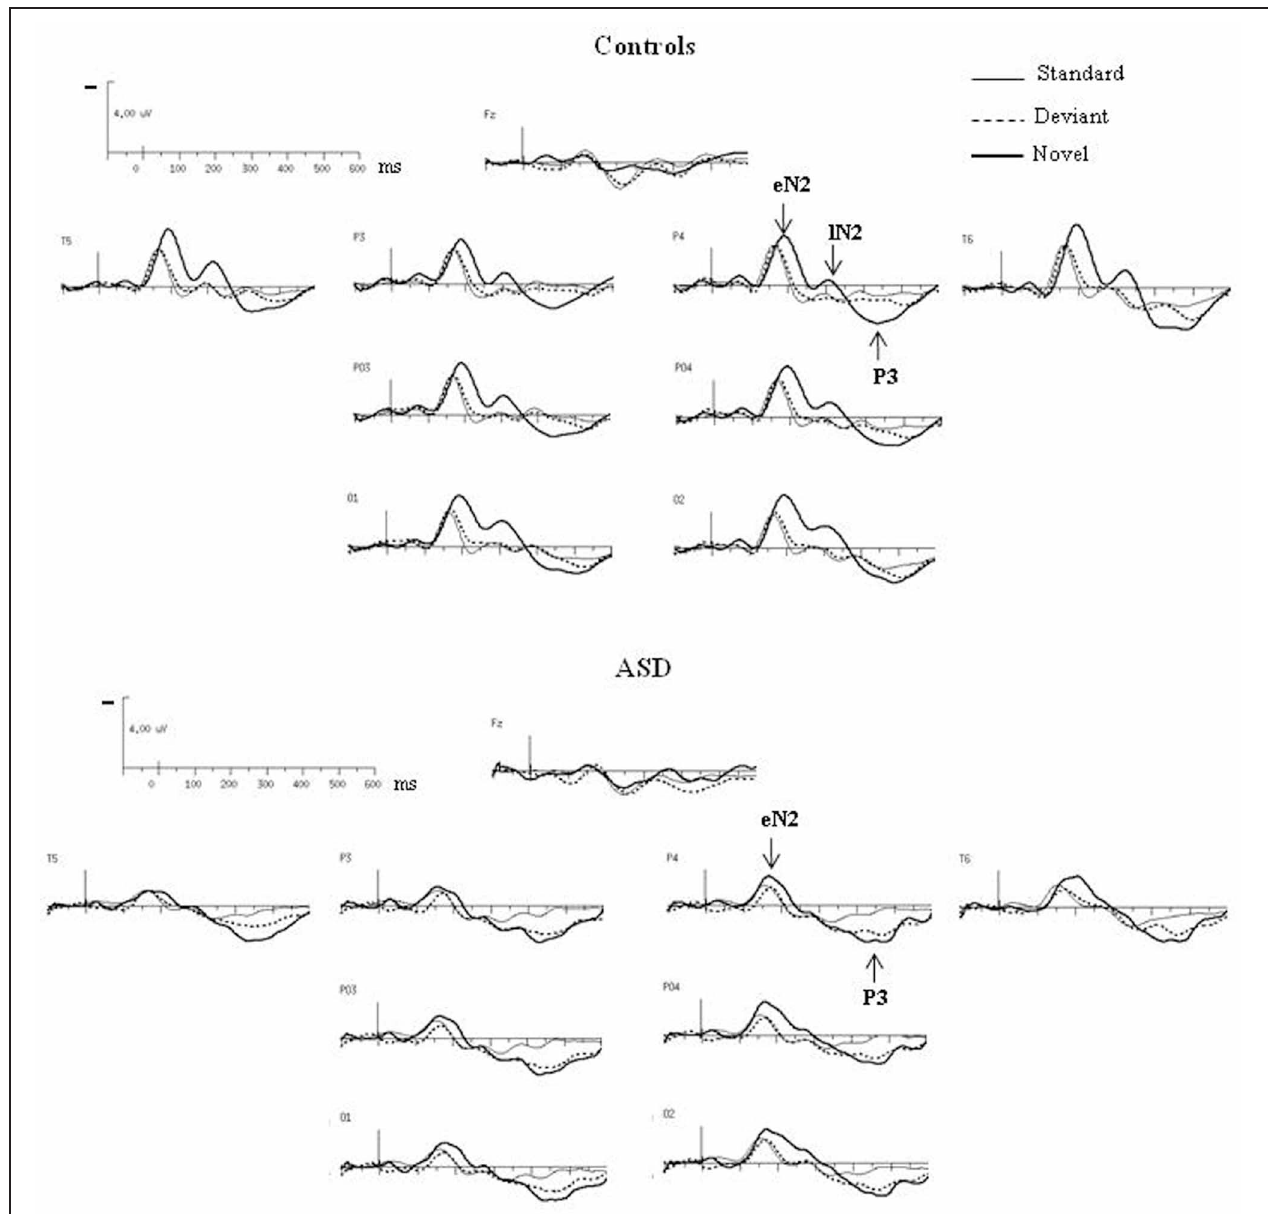
FIGURE 3 | Grand-average ERPs to the deviant and novel visual stimuli superimposed on the grand-average ERPs to the standard visual stimuli in both groups at selected electrodes.